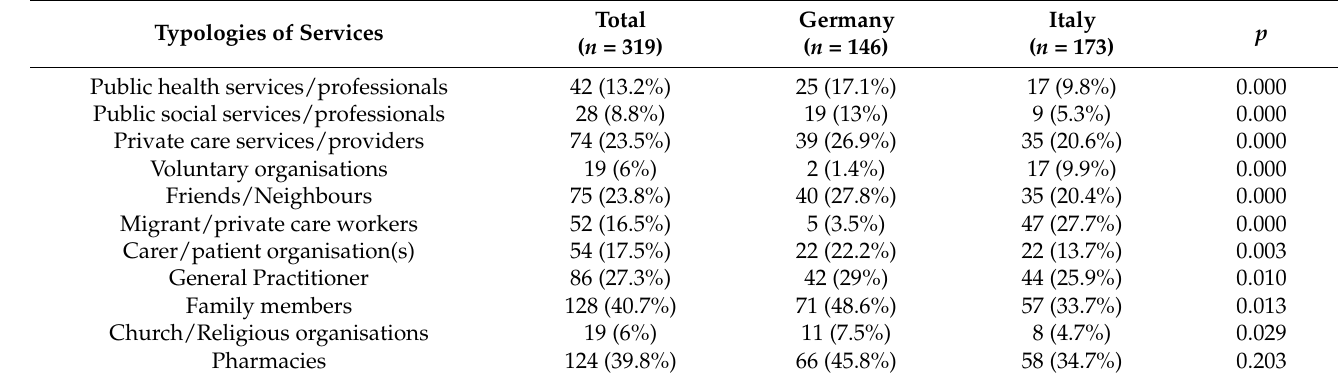
Table 3. Very/extremely effective support providers during the pandemic.